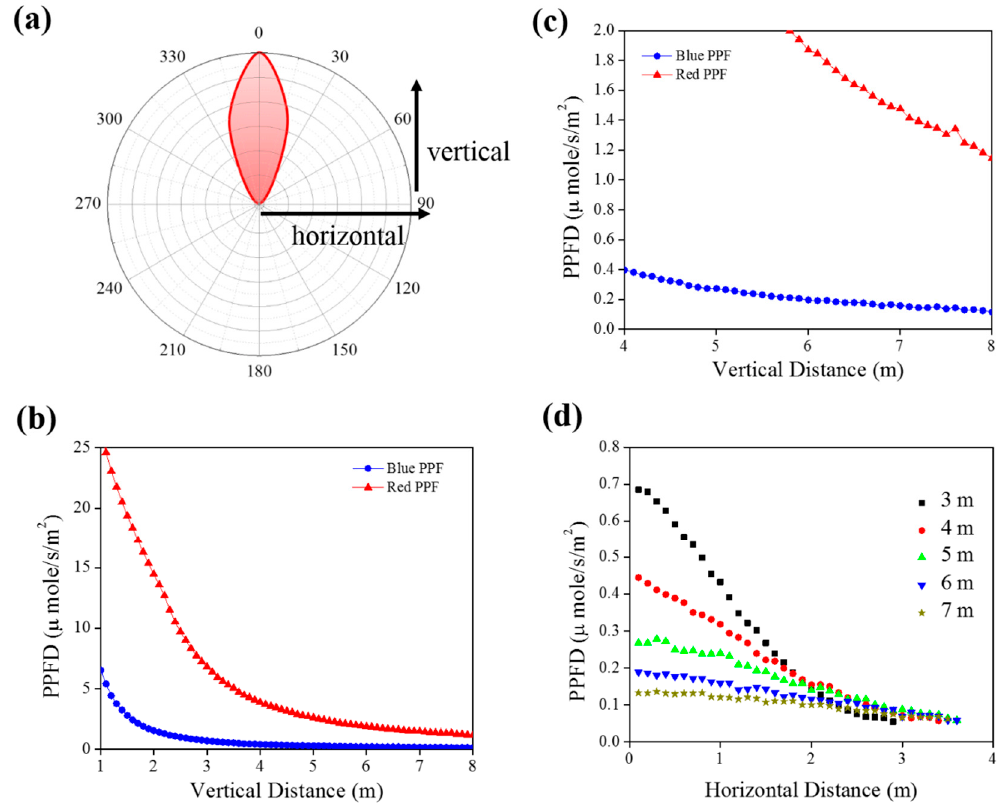
Figure 7. ( a ) Distribution pattern of the 60 × 60 lens design of the LED module. ( b ) Blue and red LED light intensity (in PPFD unit) dependent on the vertical distance. ( c ) Magnified scale from ( b ) in the vertical distance in 4 to 8 m. ( d ) Blue LED light intensity (in PPFD unit) dependent on the horizontal distance at different vertical distance between the position of LED lamp and measured positions.